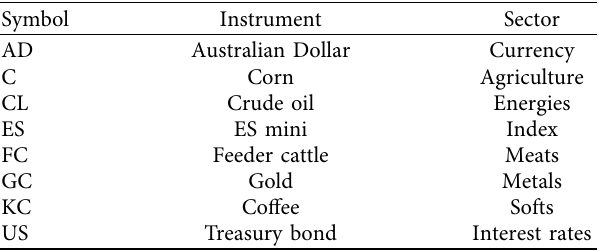
Table 1: Description of the variables used for the study.